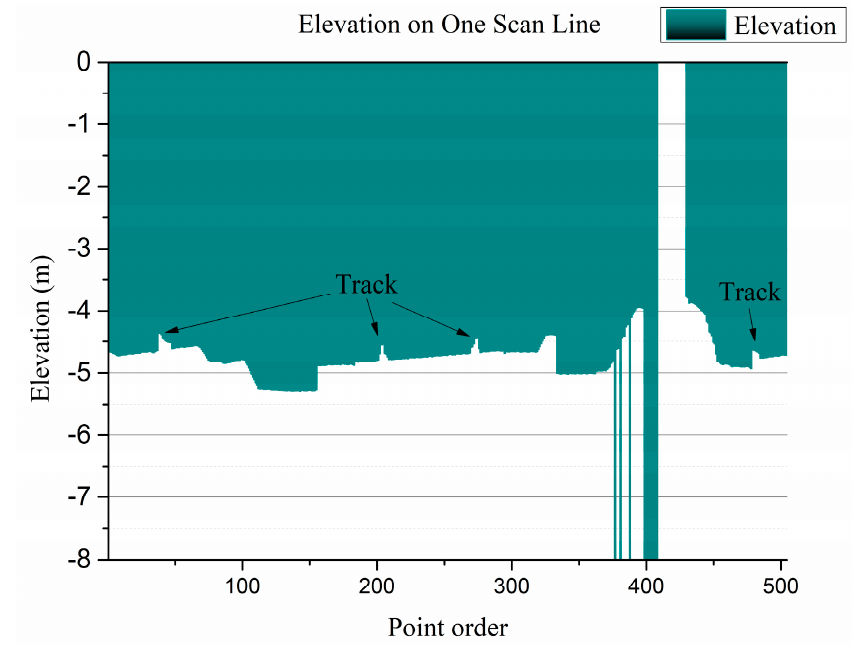
Figure 5. Elevation on one scan line.